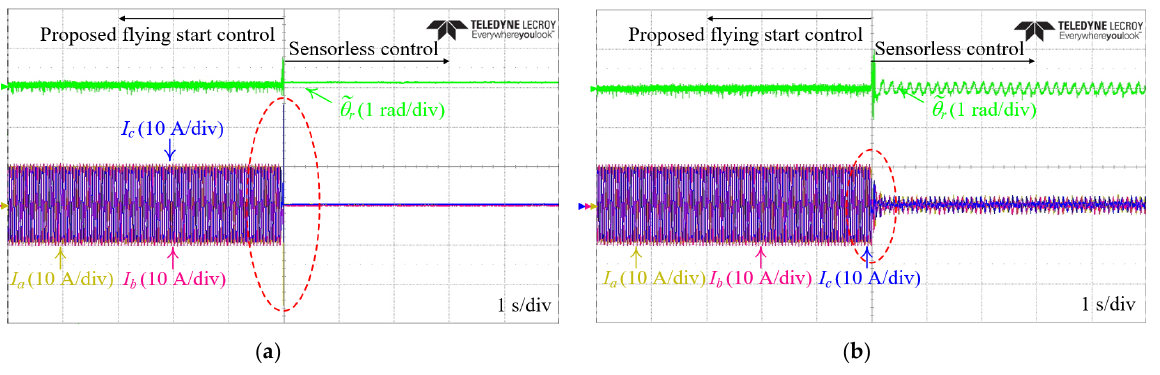
Figure 20. Experimental results comparison of the conventional method and the proposed flying start method during mode transition. ( a ) The VR-based flying start method and ( b ) the proposed flying start method.